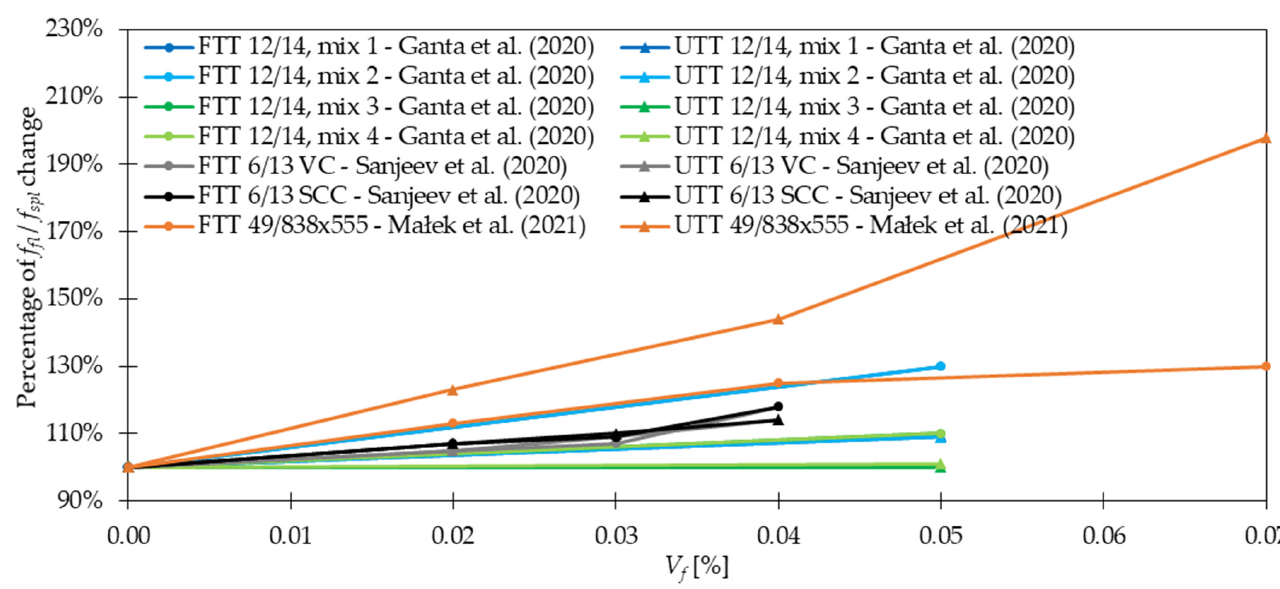
Figure 15. Change of f fl / f spl in relation to V f for different fiber geometry l f /d f [21,36,49].